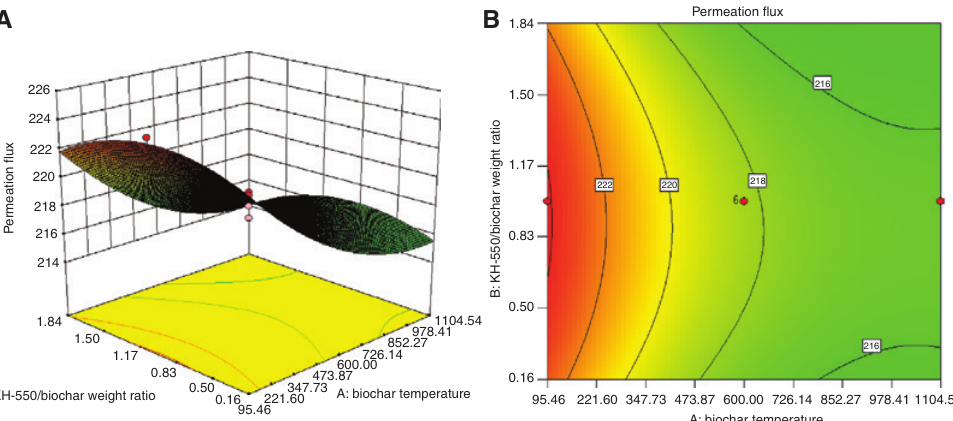
Figure 6: 3D surface plot (A) and contour plot (B) exhibiting the influences of the BB temperature and the crosslinker/BB weight ratio on the permeation